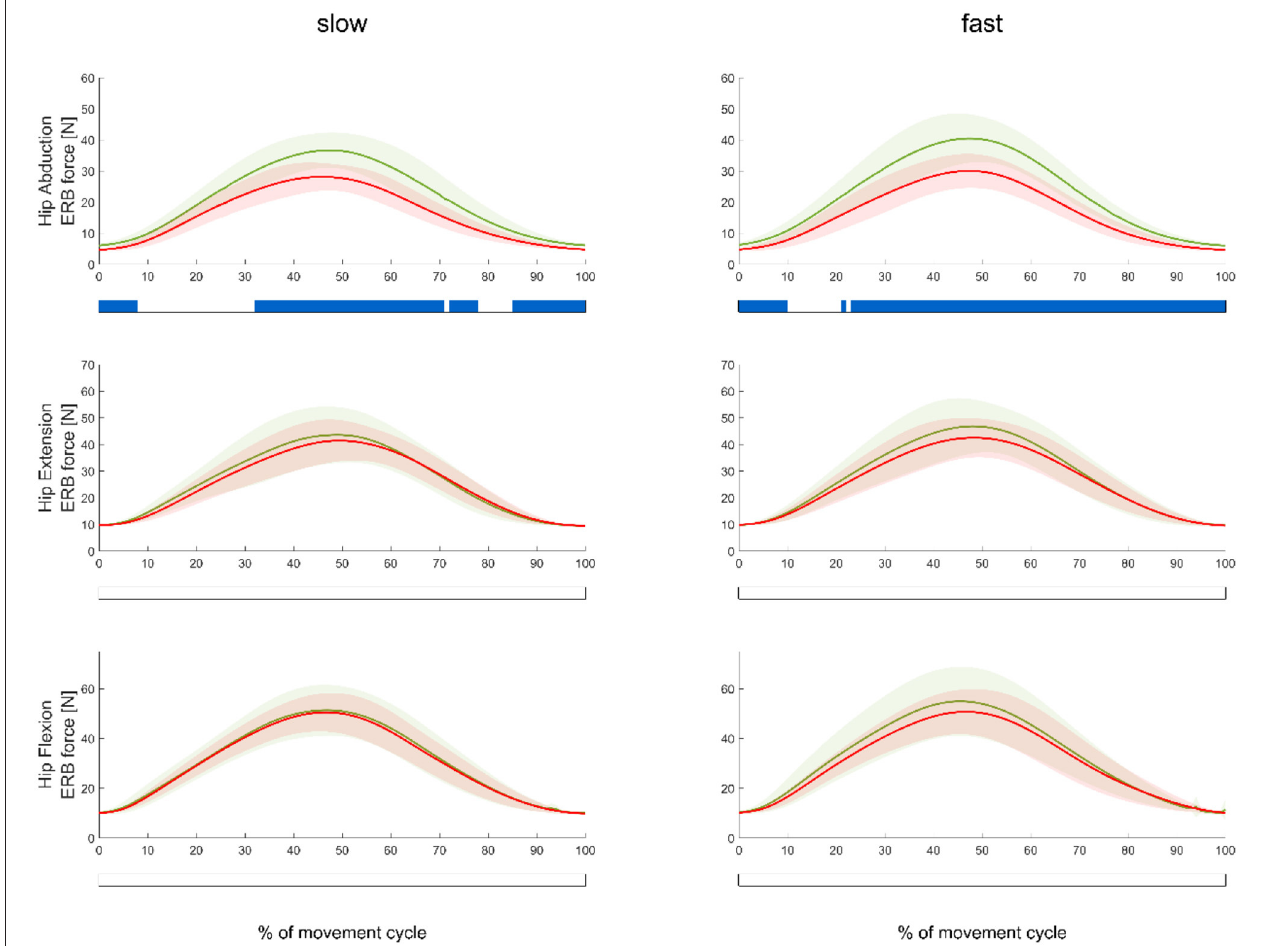
FIGURE 6 | Mean ( ± SD) ERB forces during slow (left) and fast trials (right) measured in the softer (red waveform) and stiffer (green waveform) ERBs during abduction (top), extension (middle), and flexion (bottom) exercises. Blue bars beneath each plot indicate significant differences between the forces of the softer and stiffer